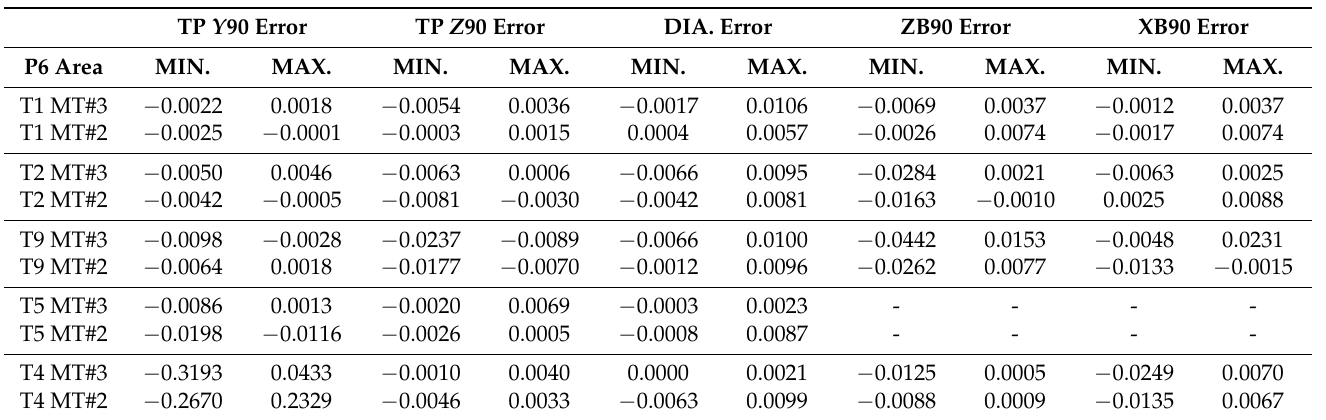
Table 8. Measurement dispersion for P6 area, B 90 ◦ head positions for the probes T1, T2, T9, T5, and B 0 ◦ head position for T4. Results in [mm].